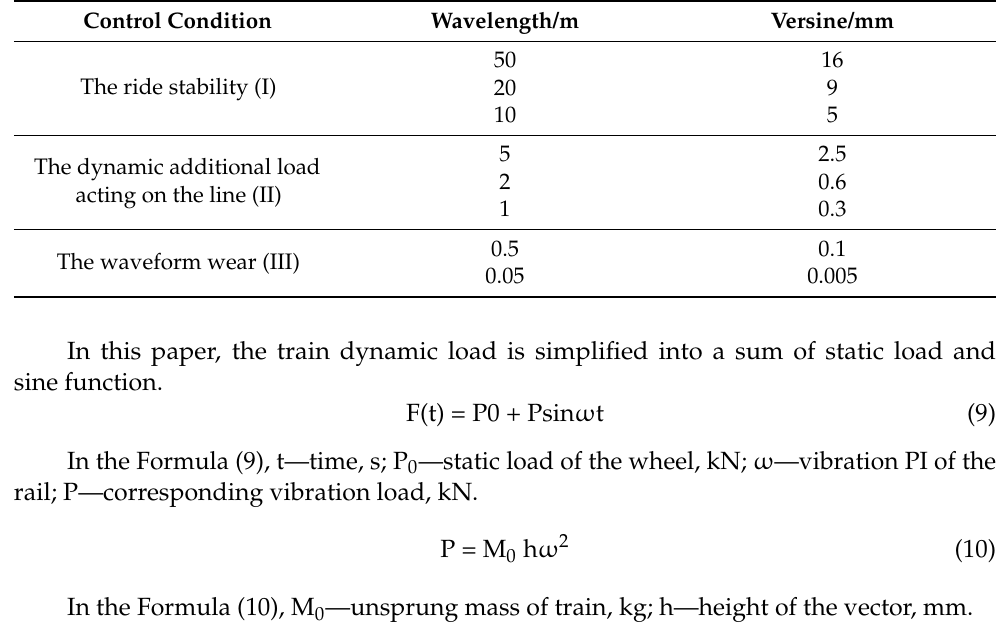
Table 6. Geometric irregularity management value for UK